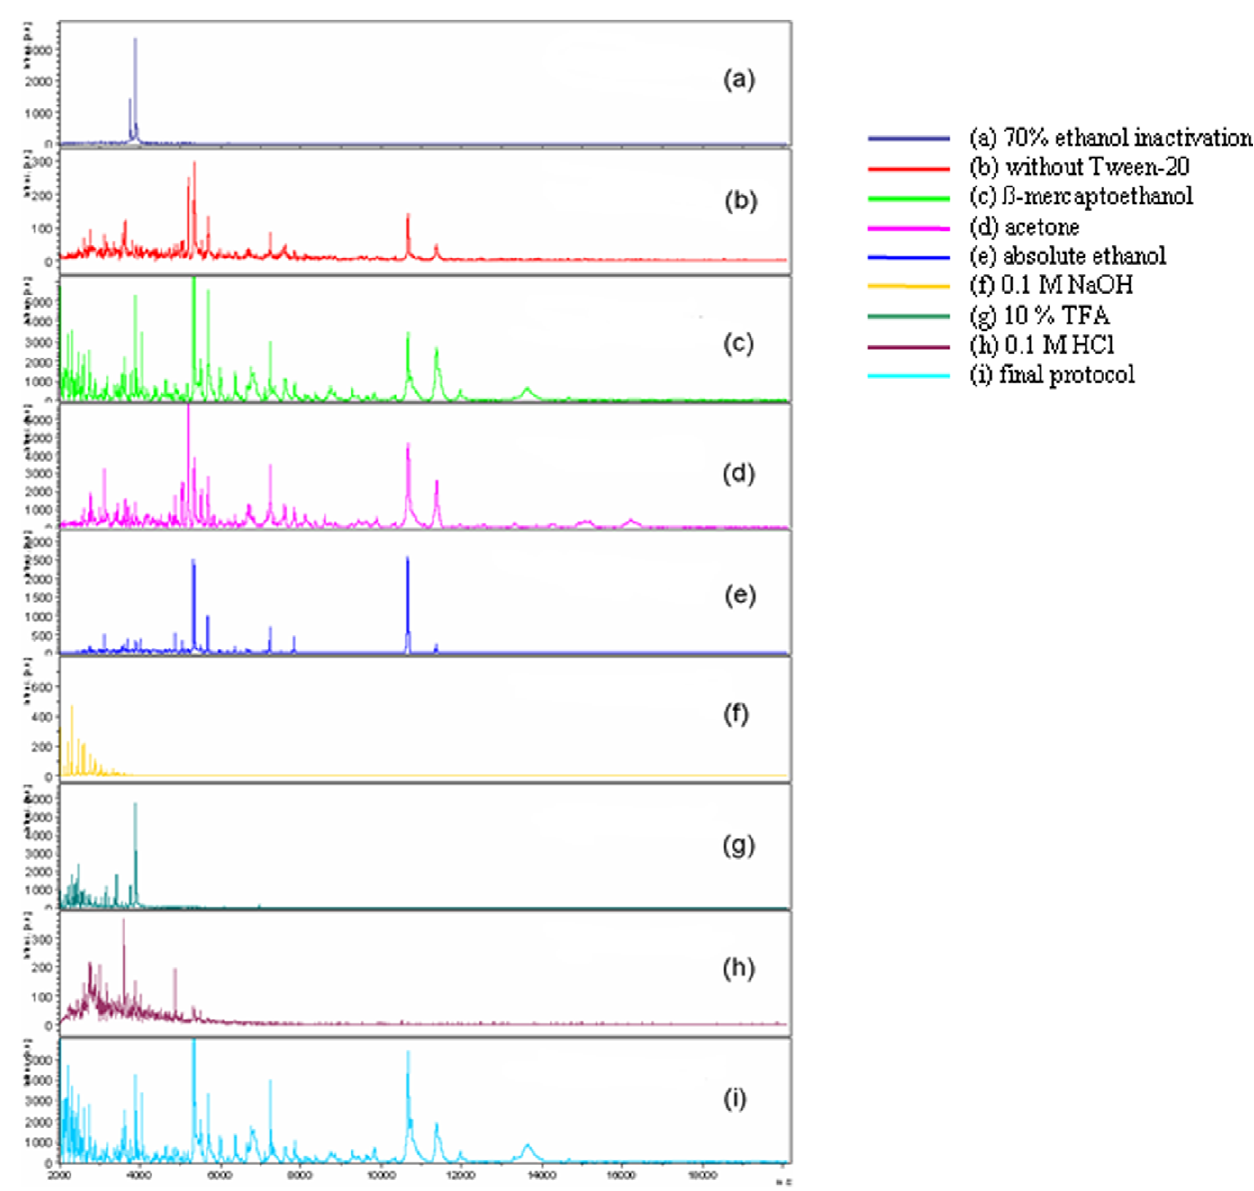
Figure 1. MALDI-TOF MS spectra obtained from the M.tuberculosis H37Rv strain using the protocols tested herein. Protocol A was used throughout; protocol B was used where mentioned (Line 2).